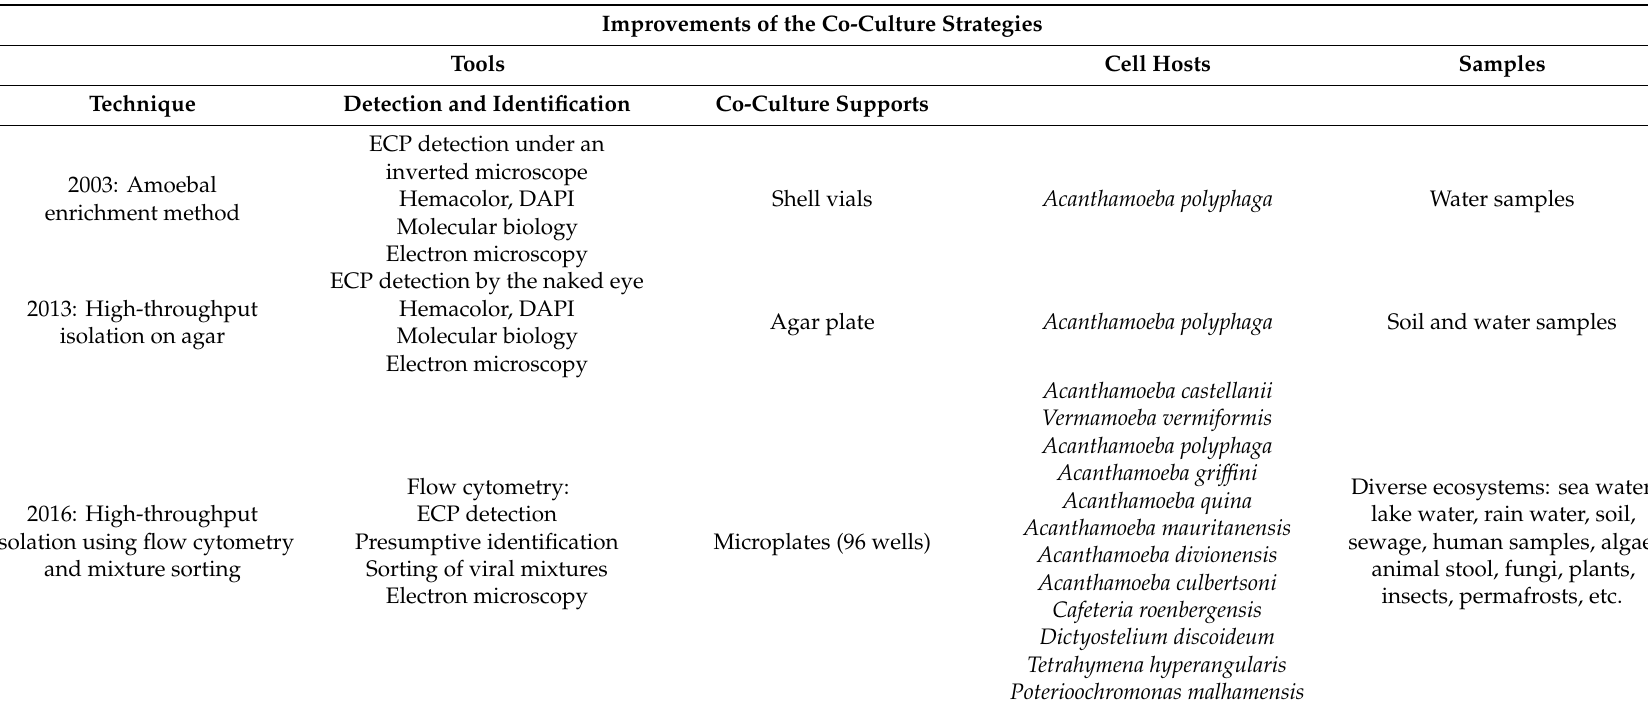
Table 2. Evolution of the co-culture strategies over the years: tools, host panels, and sample